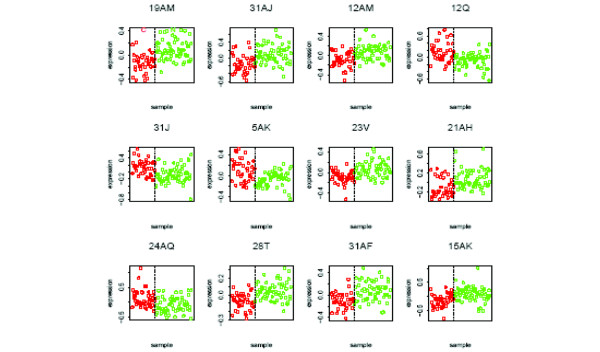
Relative expression of 13 predictive genes with the highest scores in breast-cancer and non-breast-cancer samples. Red circles represent samples from women with breast cancer and green circles represent samples from women with no signs of breast cancer. The number on the upper axis represents the position ID of predictive genes in the array (Table 3).